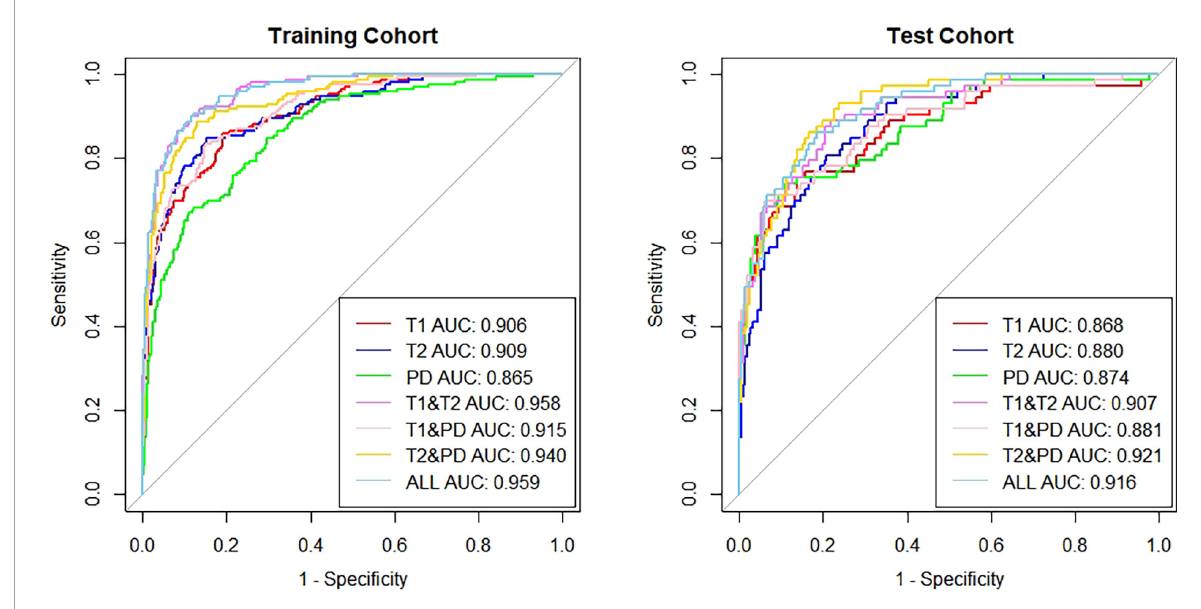
FIGURE5 The AUC of the 7 predictive models in the training group and test group.